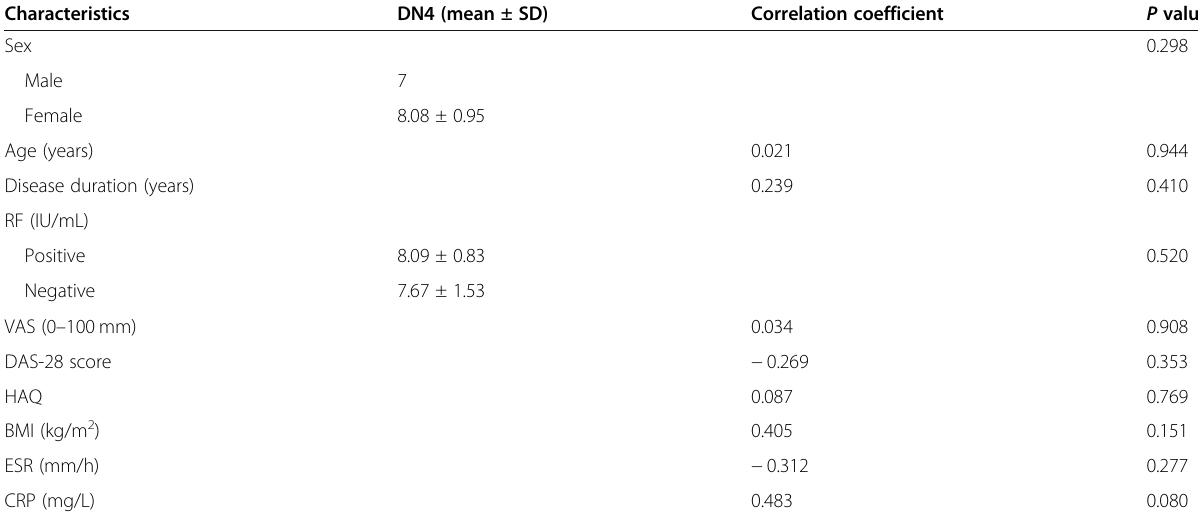
Data was expressed as means ± SD of DN4 level between males and females, or between RF positive and negative patients, and for these, p values were obtained using independent t test. The correlation between DN4 and other quantitative variables was calculated using Pearson ’ s correlation test for parametric variables and Spearman ’ s correlation test for non-parametric variables RF Rheumatoid factor, Anti-CCP Anti-cyclic citrullinated peptide, VAS Visual analog scale of pain, DAS28 Disease activity for 28 joint indices score, HAQ Health